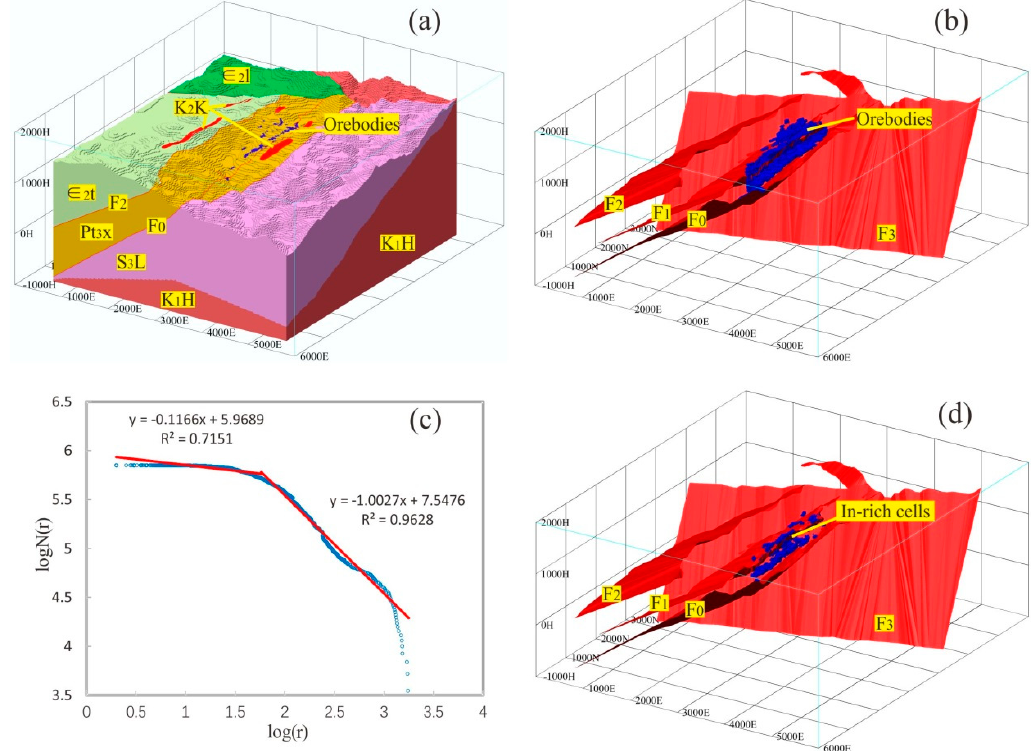
Figure 2. Geology and In-rich ore bodies model in Dulong mining area. ( a ) Geological model of mining area; ( b ) Faults and ore bodies model; ( c ) Indium-grade log–log plot of ore bodies; ( d ) Faults and In-rich ore bodies model. ∈ 2 l—Middle Cambrian Longha Formation; ∈ 2 t—Middle Cambrian Tianpeng Formation; Pt 3 x—Neoproterozoic Xinzhai Formation; K 1 H—Cretaceous granite; K 2 K— Cretaceous granite porphyry; S 3 L—Silurian granite; F 0 -F 3 —Fault number.